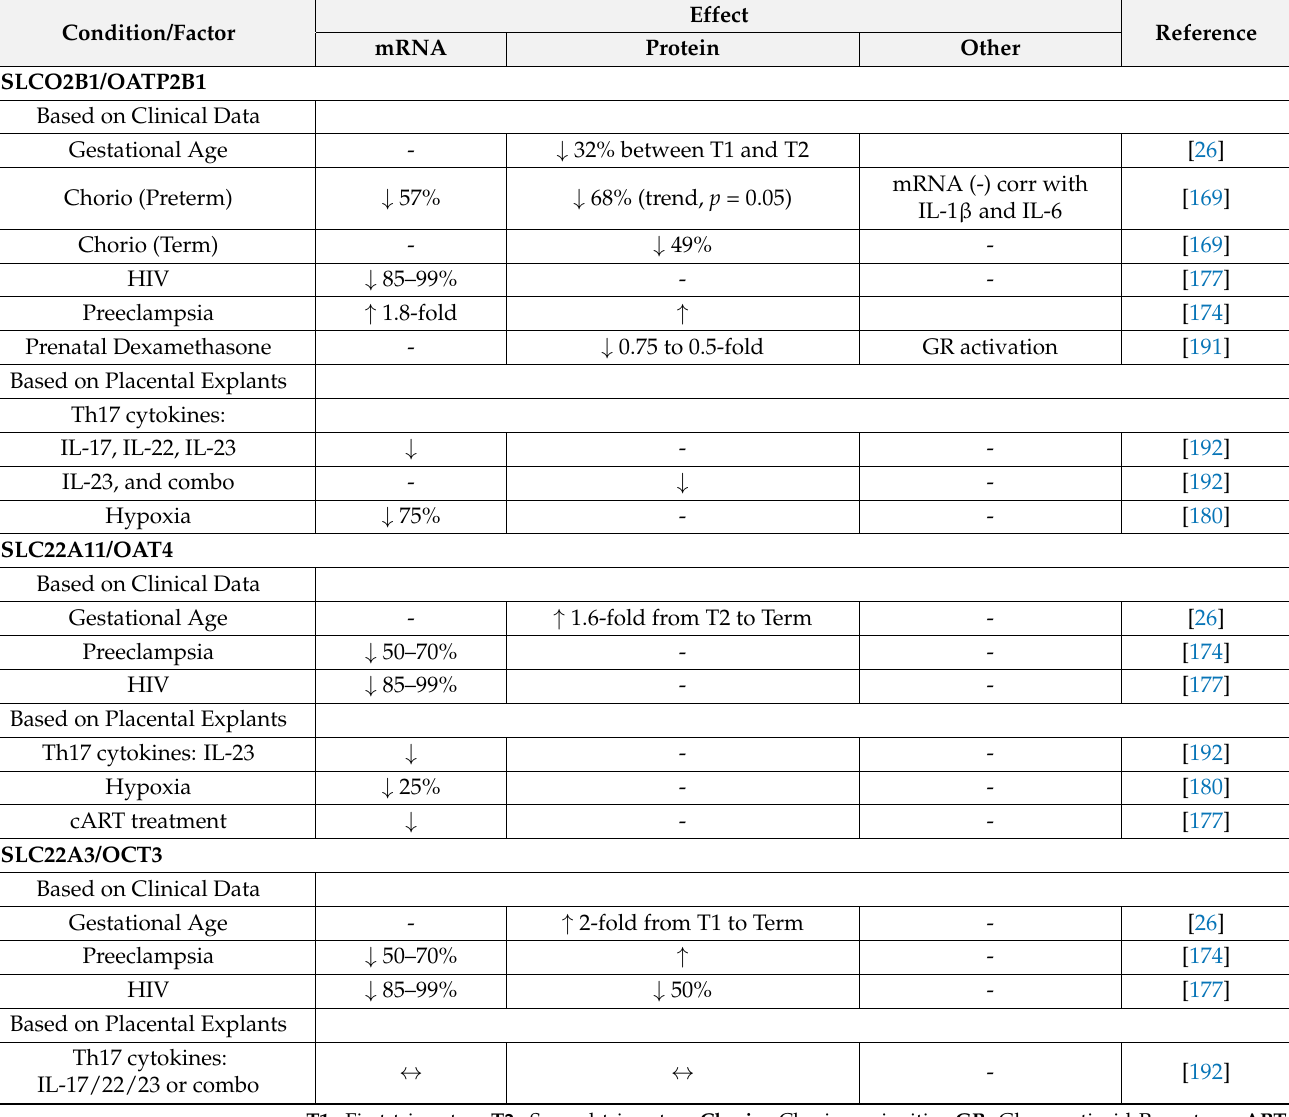
Table 3. Summary of alterations for key SLC in the placenta in different physiological/ pathological